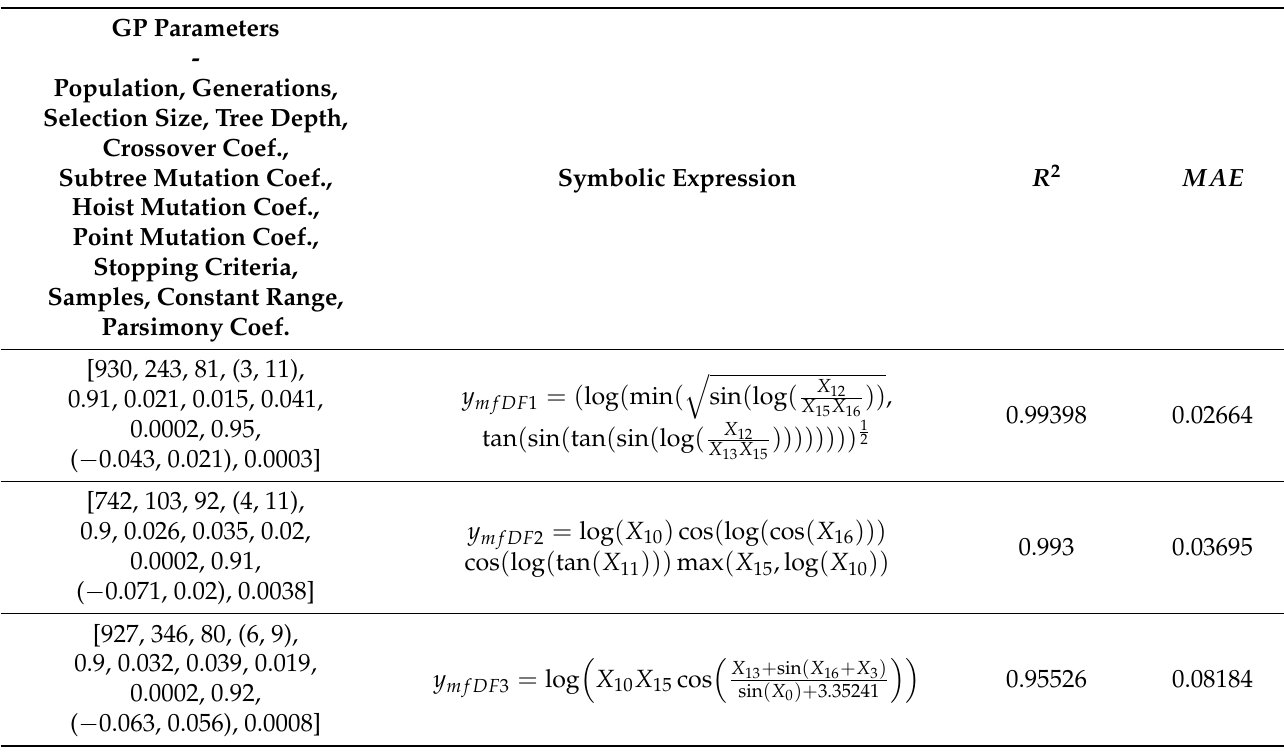
Table 4. Three best symbolic expressions for fuel flow estimation with decay state coefficients with corresponding R 2 and MAE score.